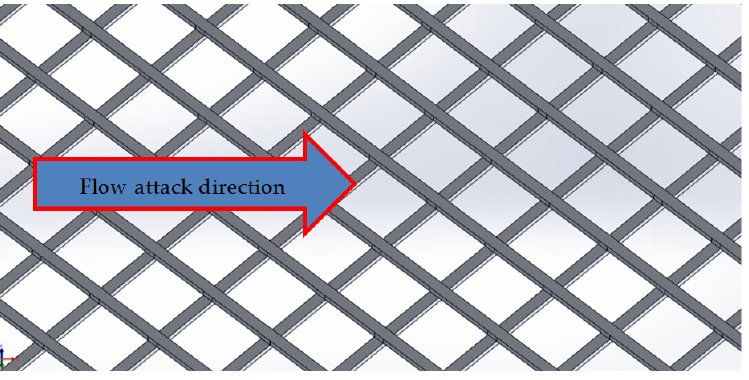
Figure 4. Spacer used to fill DCMD module’s channels including orientation, geometry, and flow attack angle. attack